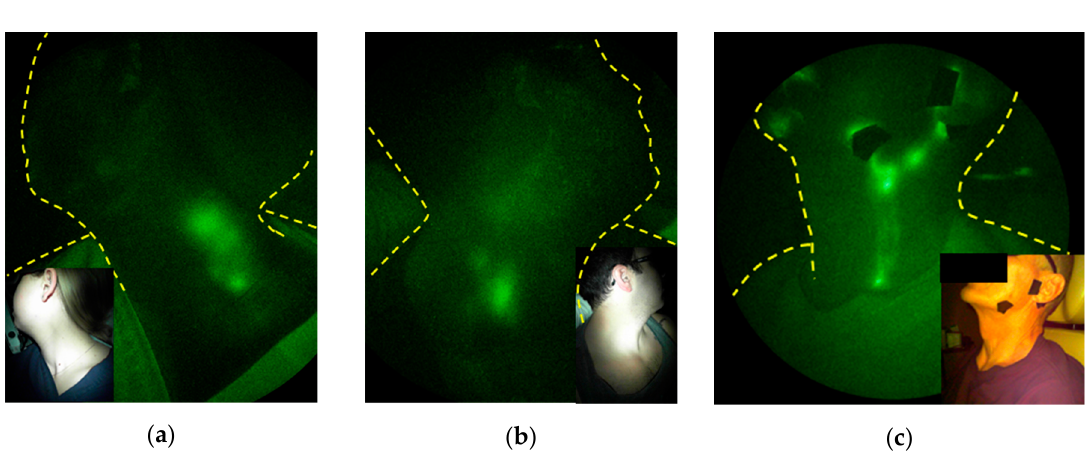
Figure 5. Typical NIRF-LI images of the lympho-jugular lymphatics draining to the ( a ) cervical and ( b ) supraclavicular lymph nodes following the injection of contrast agent into the palatine tonsils and ( c ) the external lymphatics draining to the supraclavicular lymph nodes following facial intradermal injections (adapted from [28], Rasmussen, JC, et al. 2018). Injection sites are covered with round bandages and/or black vinyl tape. The brightness and contrast of the images have been adjusted to facilitate the visualization of the 16-bit imaging depth.